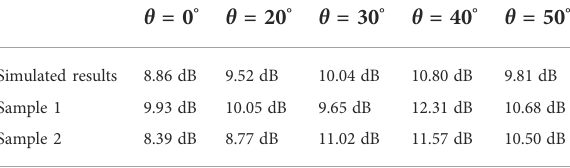
TABLE 4 Bistatic RCS reduction in mirror direction of the simulated model and samples 1 and 2 in different θ .